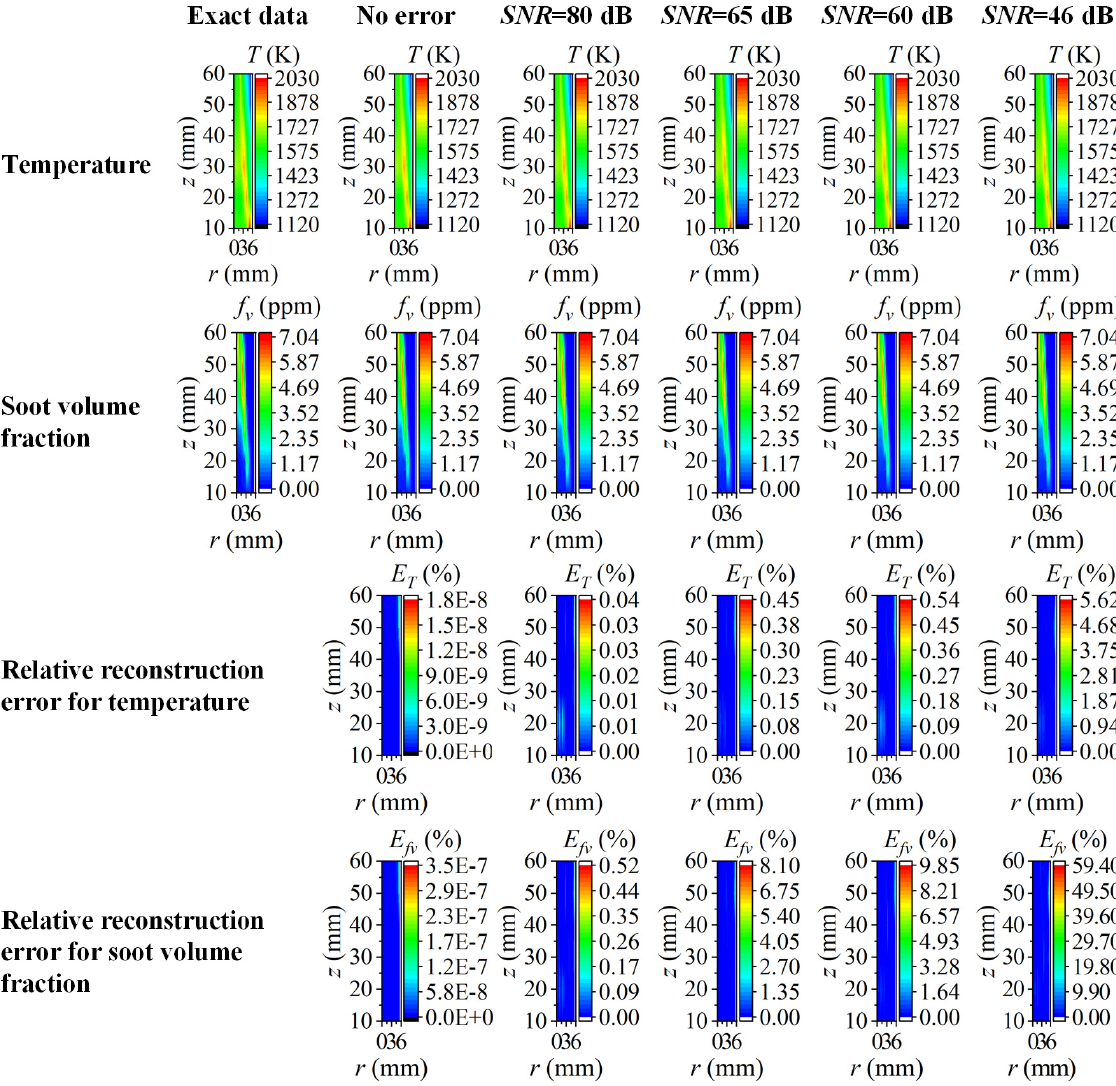
Figure 18. The reconstructed 2D flame temperature and soot volume fraction with corresponding relative reconstruction error at different SNR .